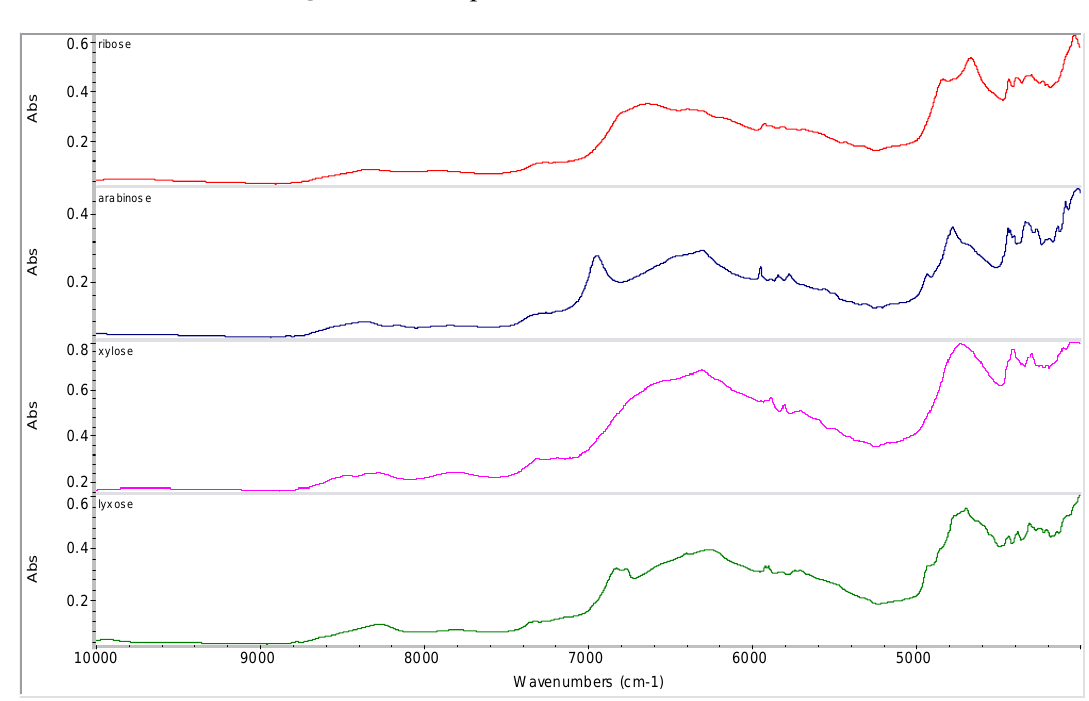
Figure 5. NIR spectra of discussed